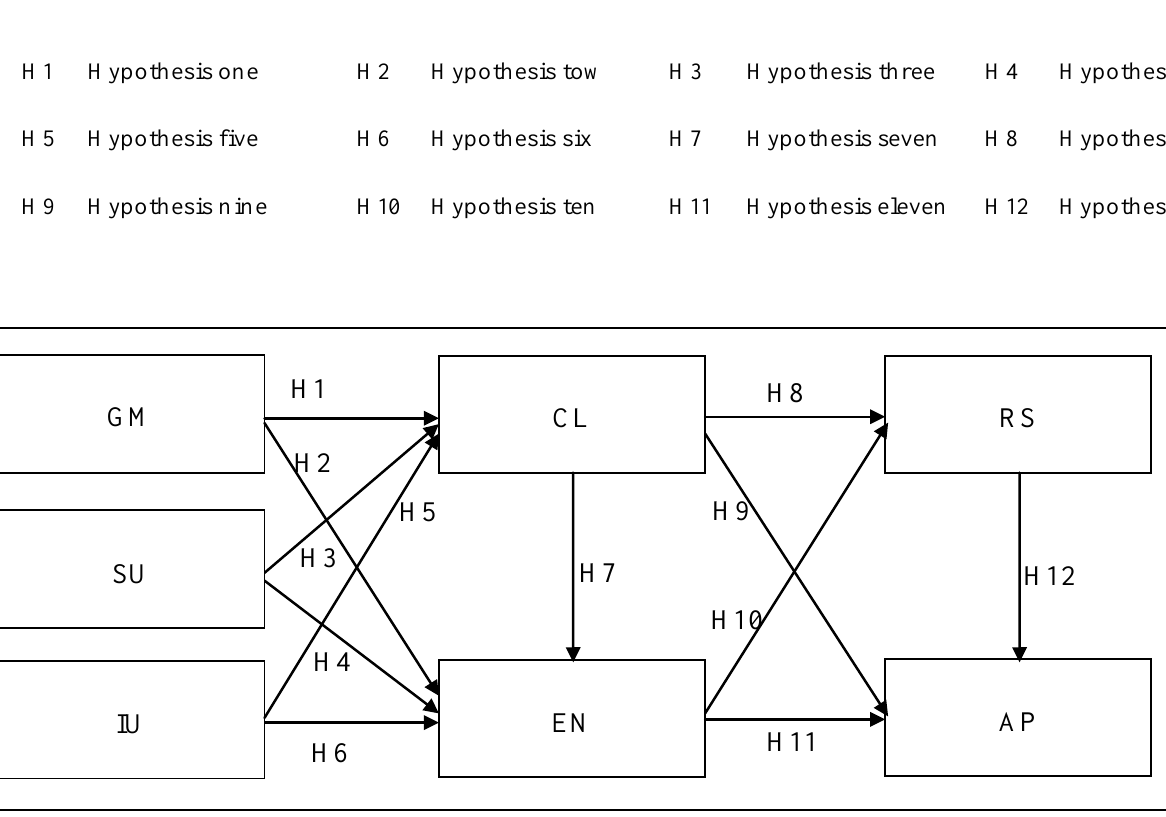
Social Media Use and Interactivity with Group Members and